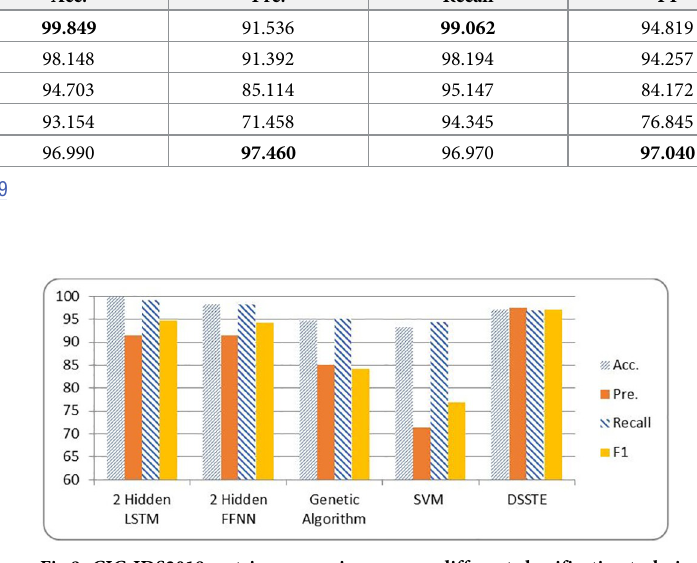
Fig 9. CIC-IDS2018 metrics comparison among different classification